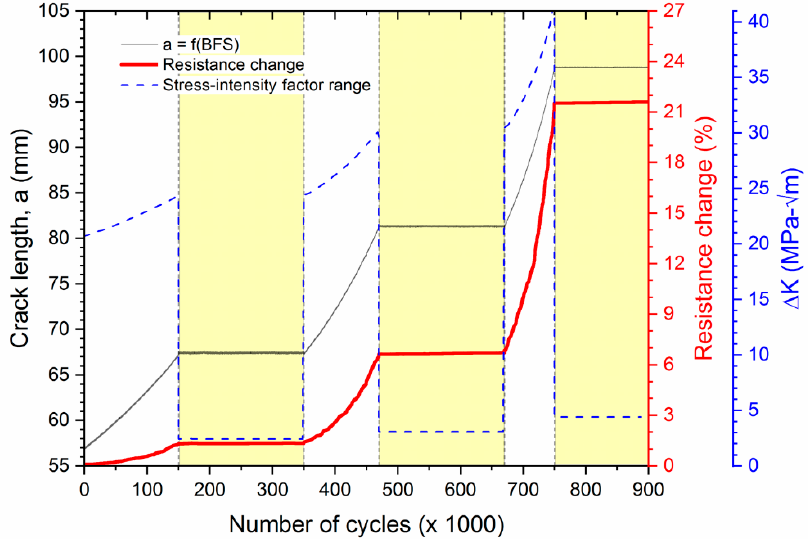
Figure 10. Crack length, electric resistance changes of the CNT sensor, and range of stress intensity factor, Δ K vs. number of loading cycles. The three near-threshold crack propagation regimes are shaded in yellow.